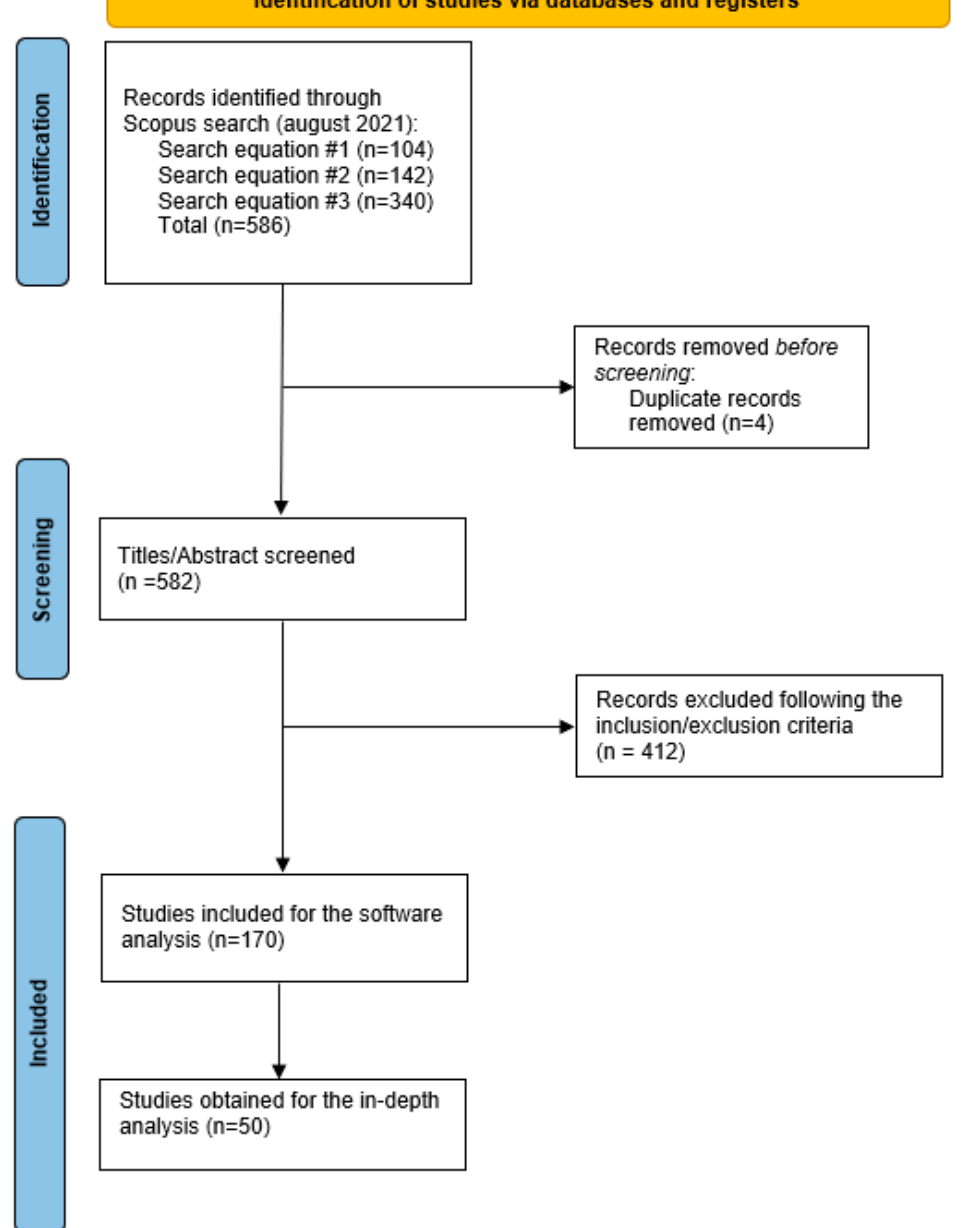
Figure 1. The PRISMA 2020 inclusion–exclusion flowchart.